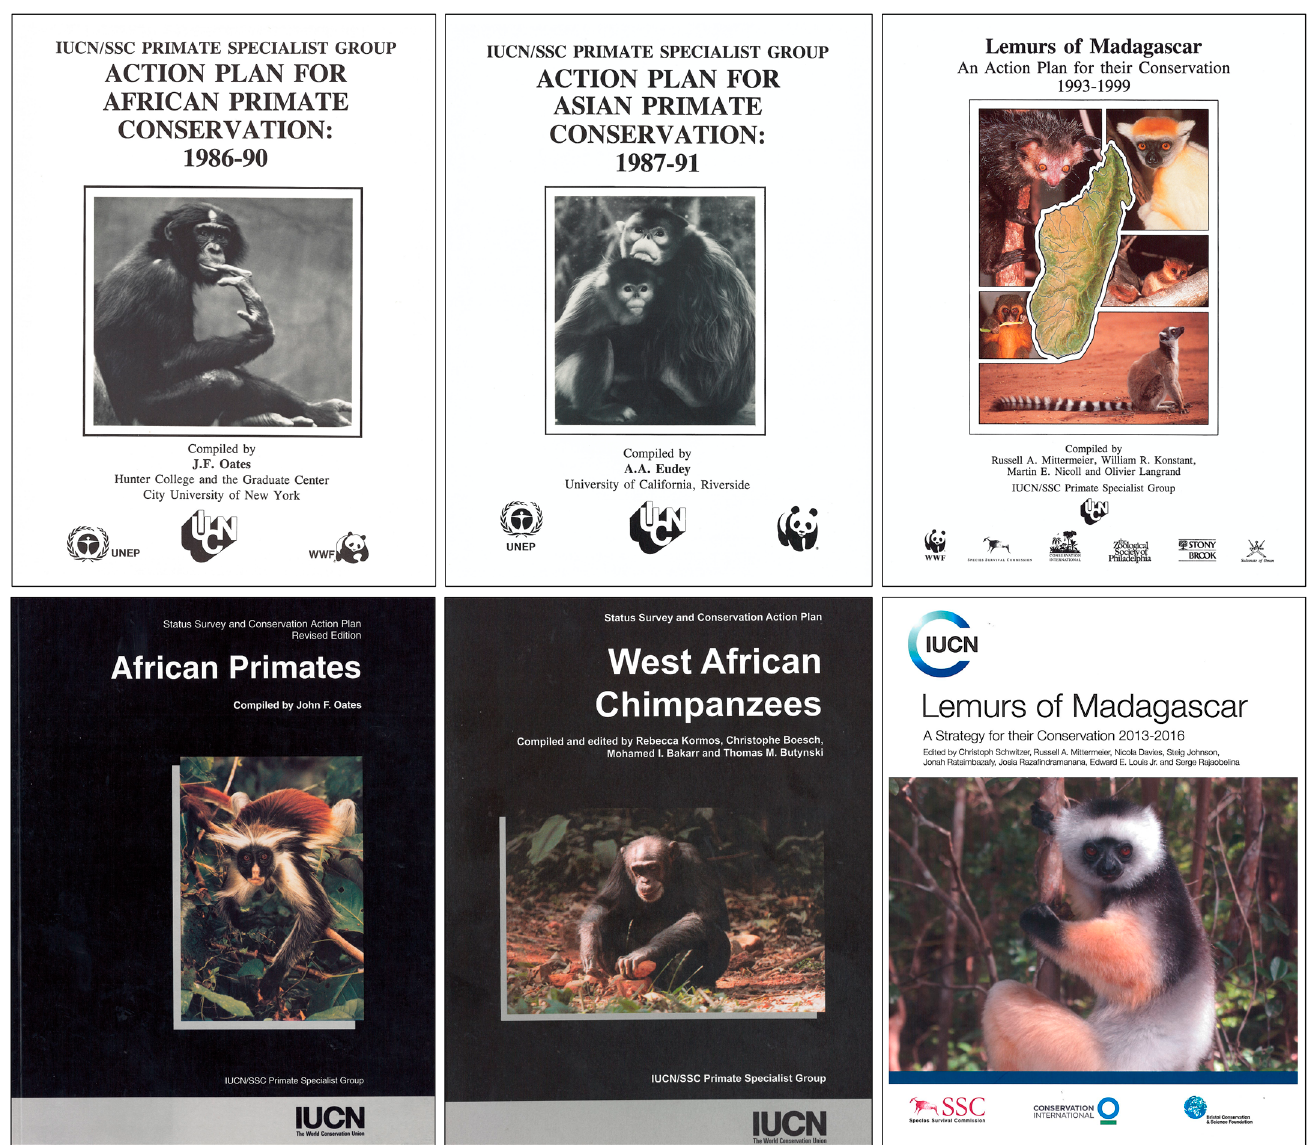
Figure 1. Covers of some IUCN SSC PSG primate conservation action plans. Plans pictured (top row then the bottom row, left to right): Oates [13], Eudey [14], Mittermeier et al. [15], Oates [20], Kormos et al. [16], and Schwitzer et al.